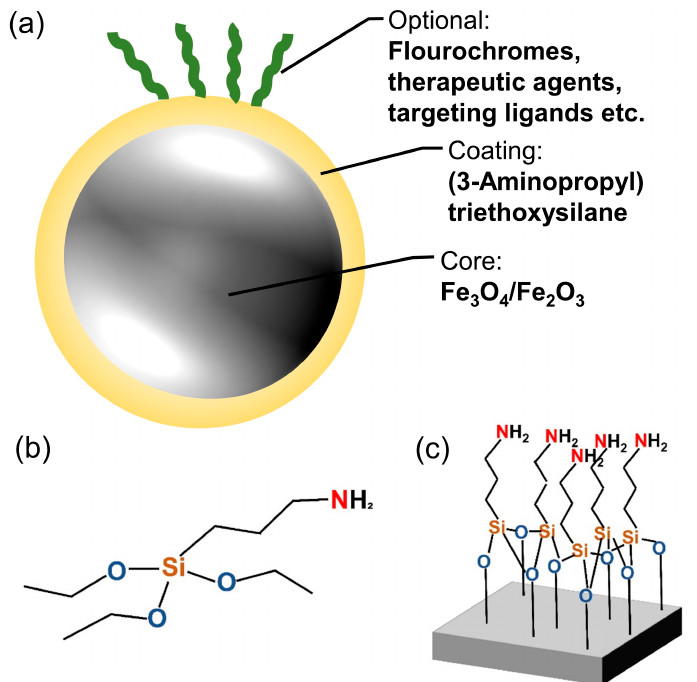
Figure 1. Superparamagnetic iron oxide nanoparticle (SPION) and coating structure. ( a ) Sketch of a SPION with (3-Aminopropyl)-Triethoxysilane (APTES) coating and optional additives. ( b ) Structural formula of APTES. ( c ) Structural formula of APTES on a surface.